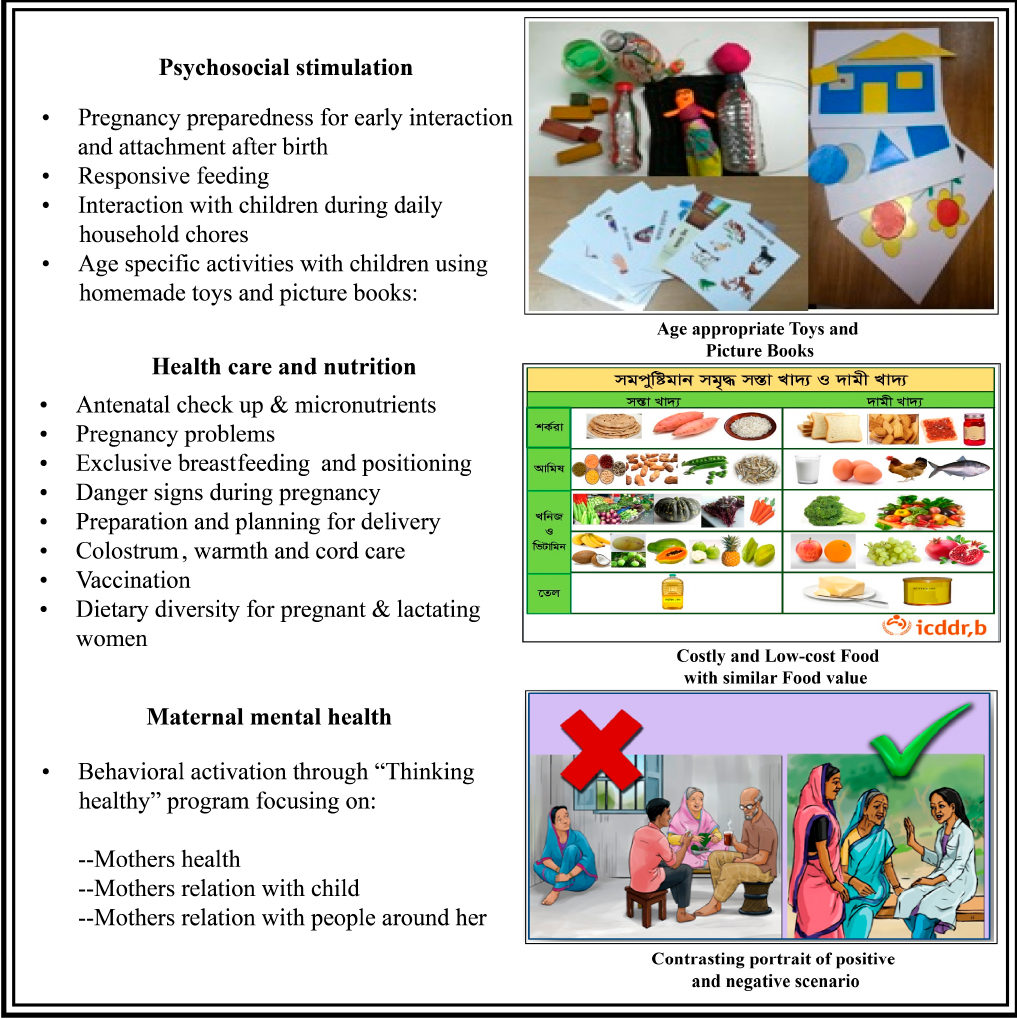
Figure 1. Integrated intervention components.